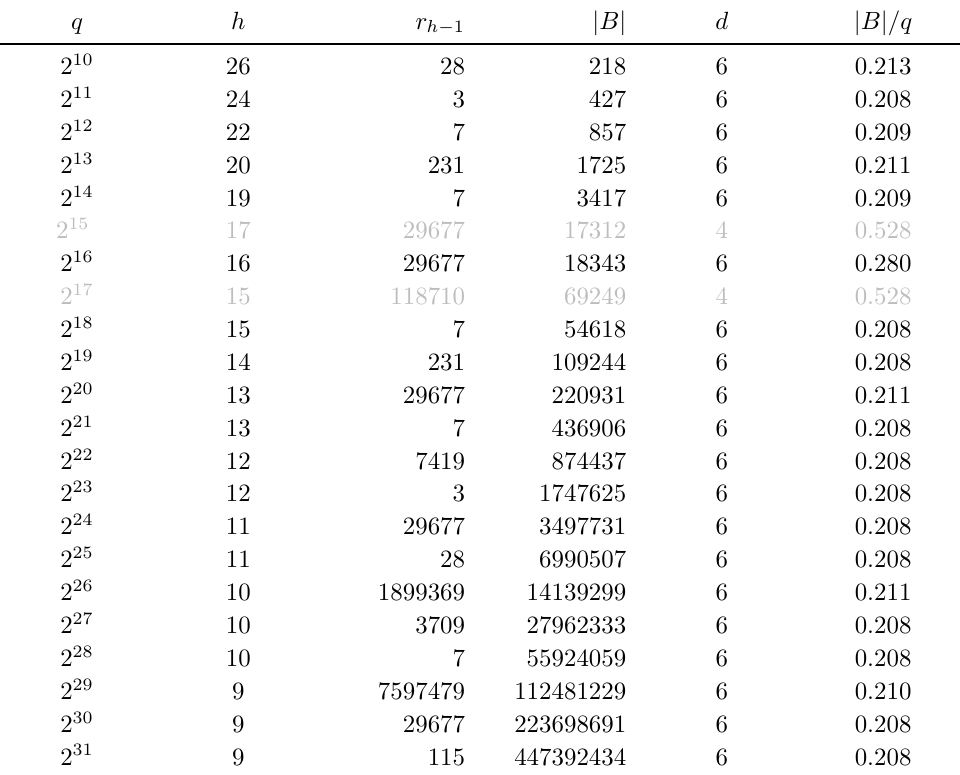
Table 6: Bucket sets over BLS12-381